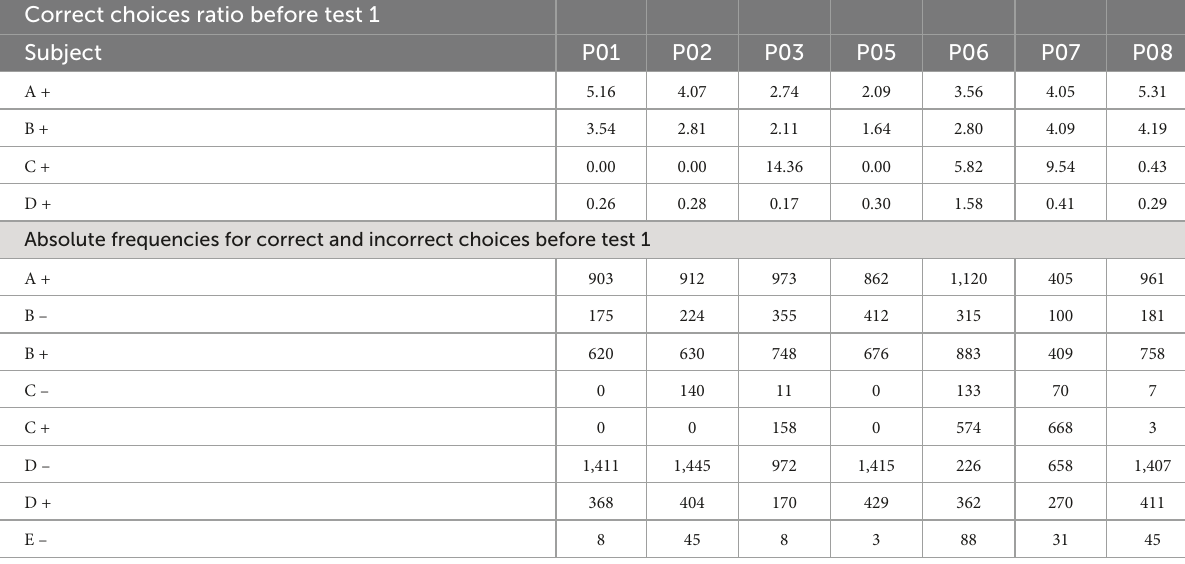
TABLE 2 Correct responses ratio for each subject before test